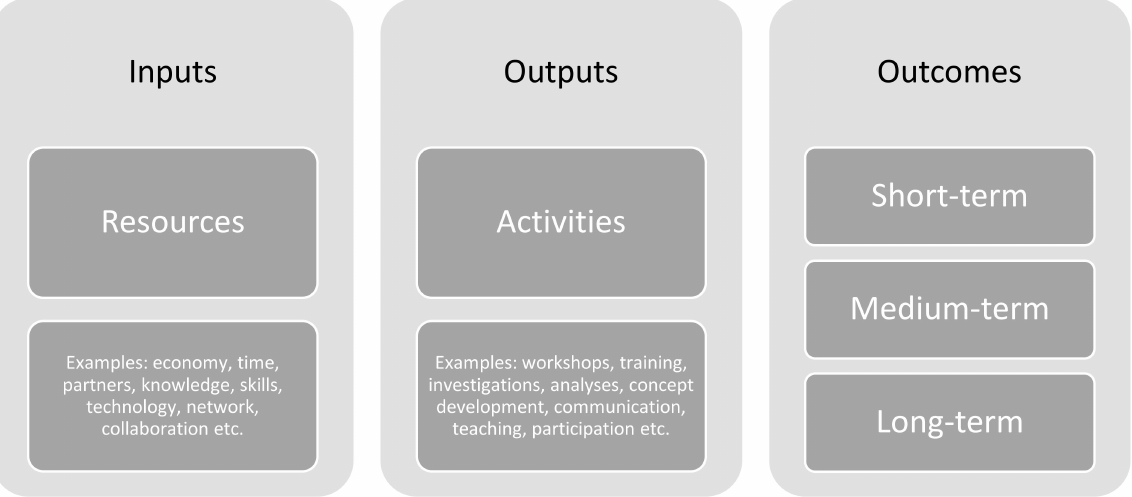
Figure 3. Outline of logic model for interventions in the HeLP